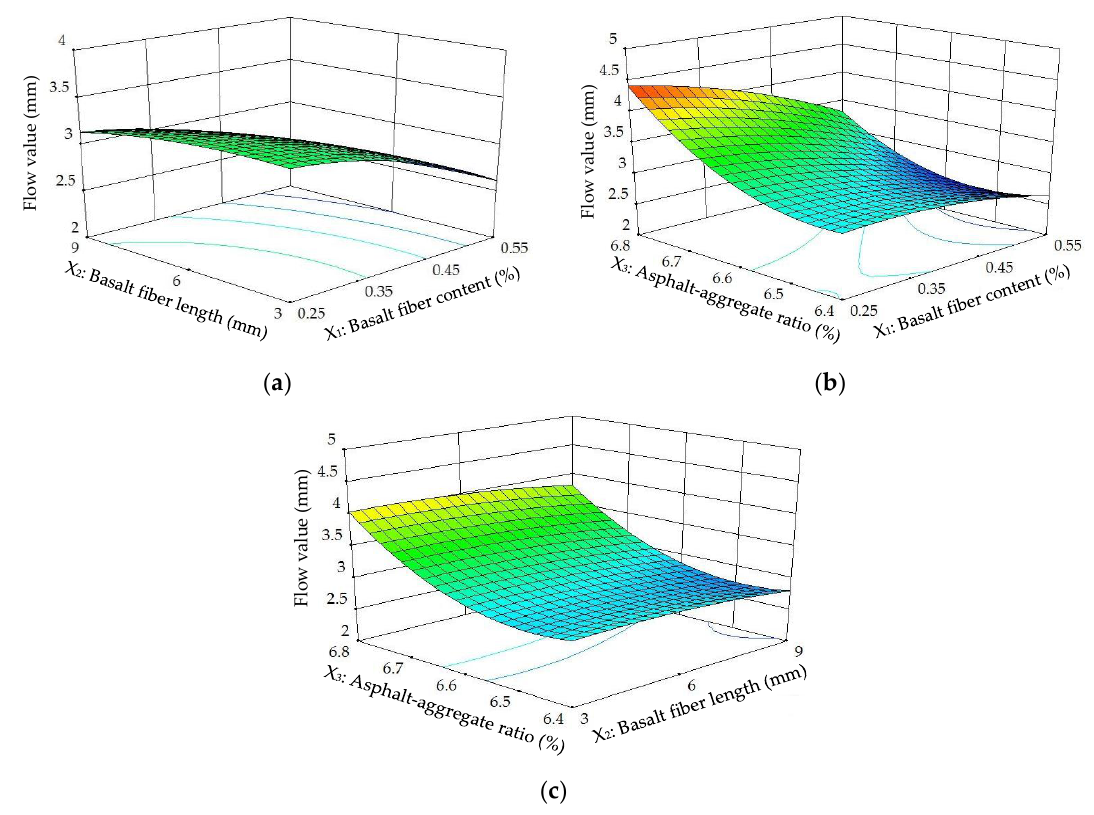
Figure 9. Response surface plots between FV and factors: ( a ) Factors: BFC and BFL at AAR = 6.6%; ( b ) Factors: BFC and AAR at BFL = 6 mm; ( c ) Factors: BFL and AAR at BFC = 0.4% Analysis of Air Voids ( VA